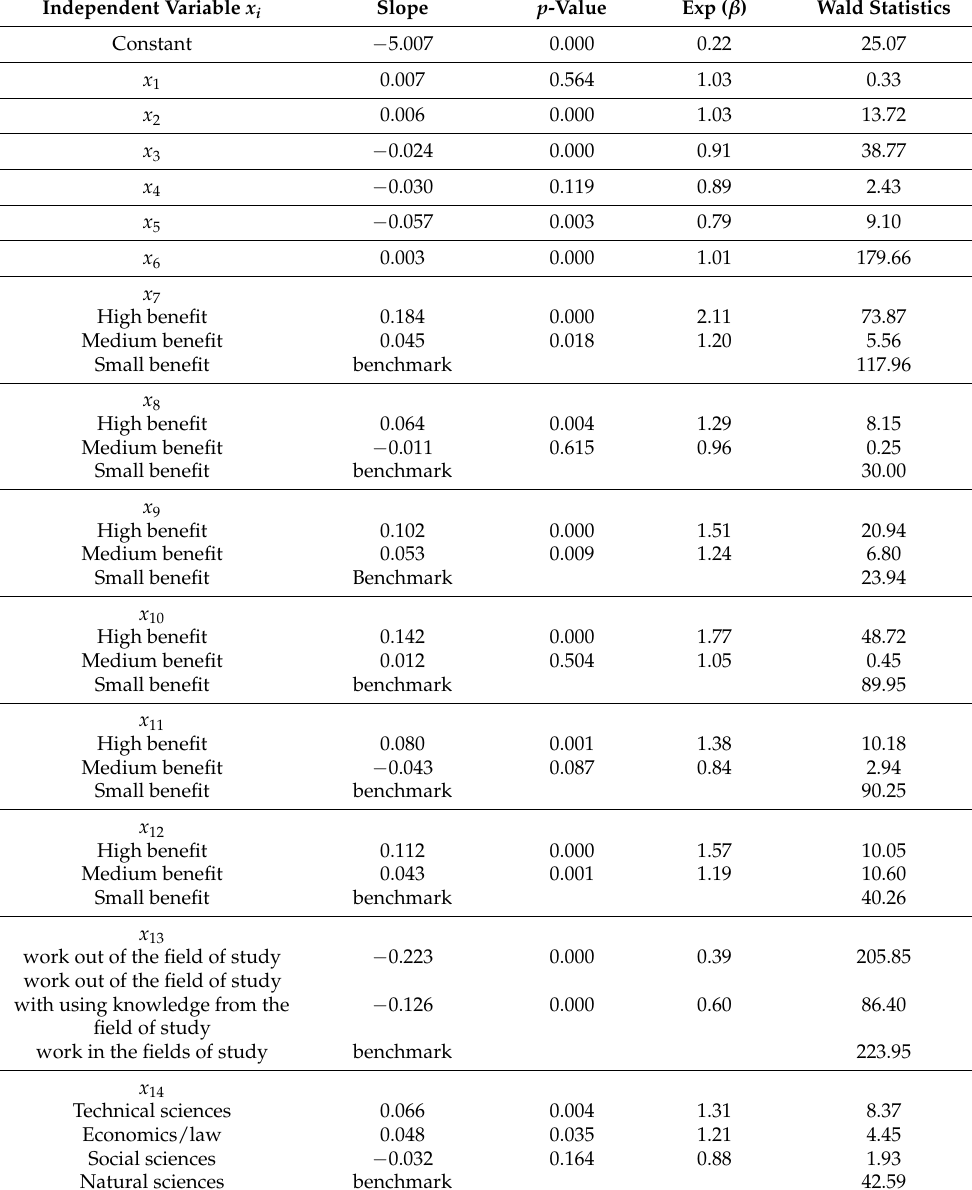
Table 2. Results of the logit model and logistic